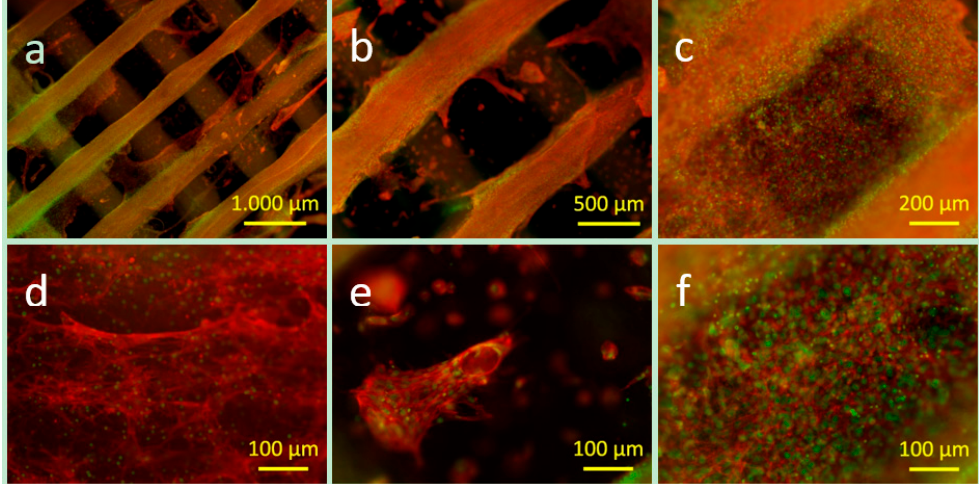
Figure 13. Fluorescence microscope images ( a – f ) of the actin cytoskeleton (red) and the cell nuclei (green) of ST2 cells in a PCL-PEG ADA-GEL construct after 28 days of incubation of different magnification: ( a , b ) overview images; ( c ) densely packed area of the cells covering both materials; ( d ) cell morphology on the hard phase; ( e ) cell agglomerate and spread single cells in hydrogel; and ( f ) densely packed area of cells (hydrogel phase).